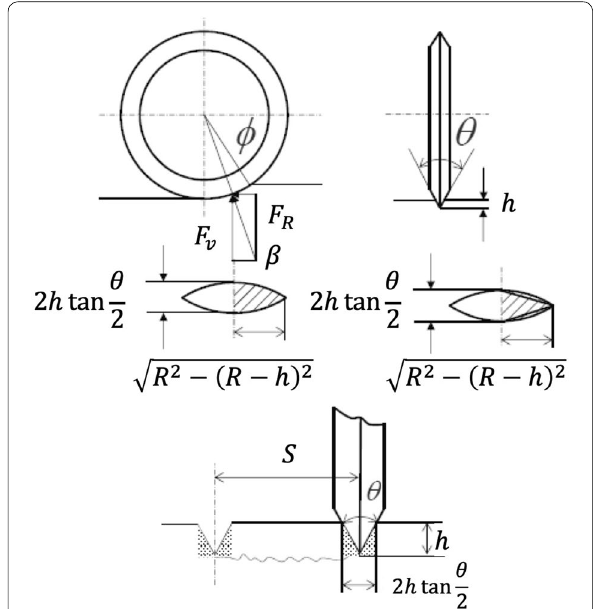
Figure 7 Principle of disc cutting the